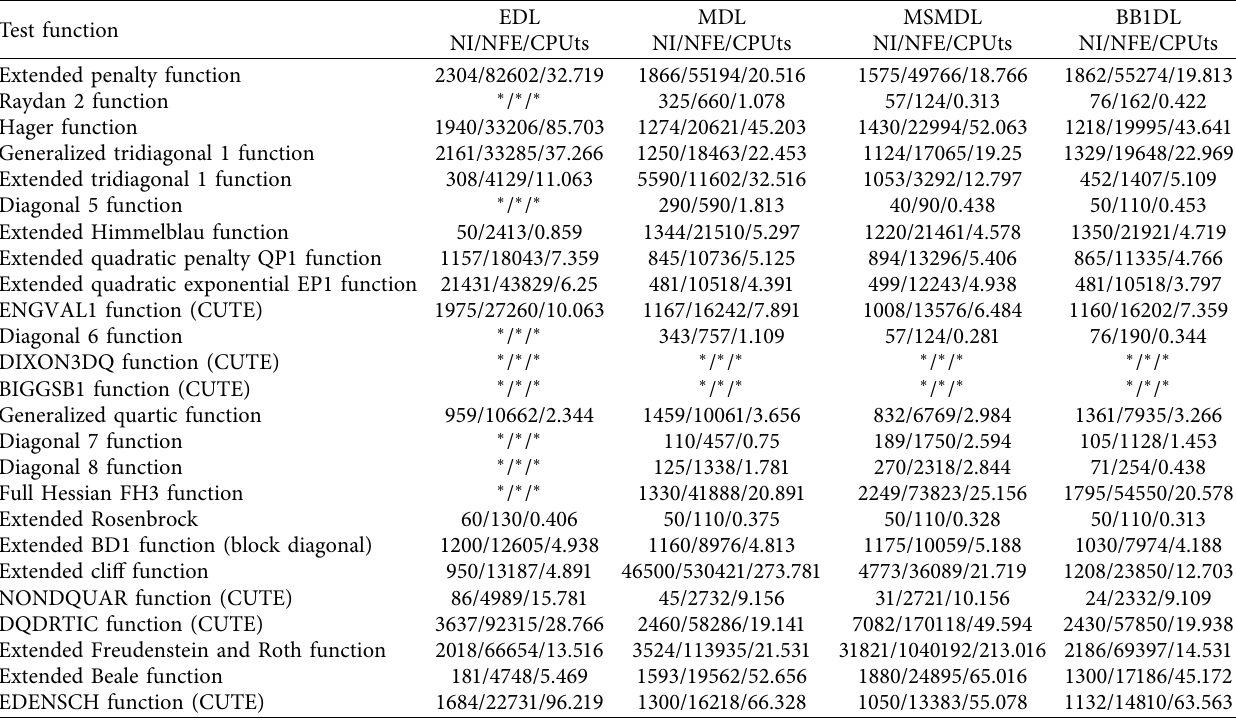
Table 5: Summary test results of EDL, MDL, MSMDL, and BB1DL methods for NI, NFE, and